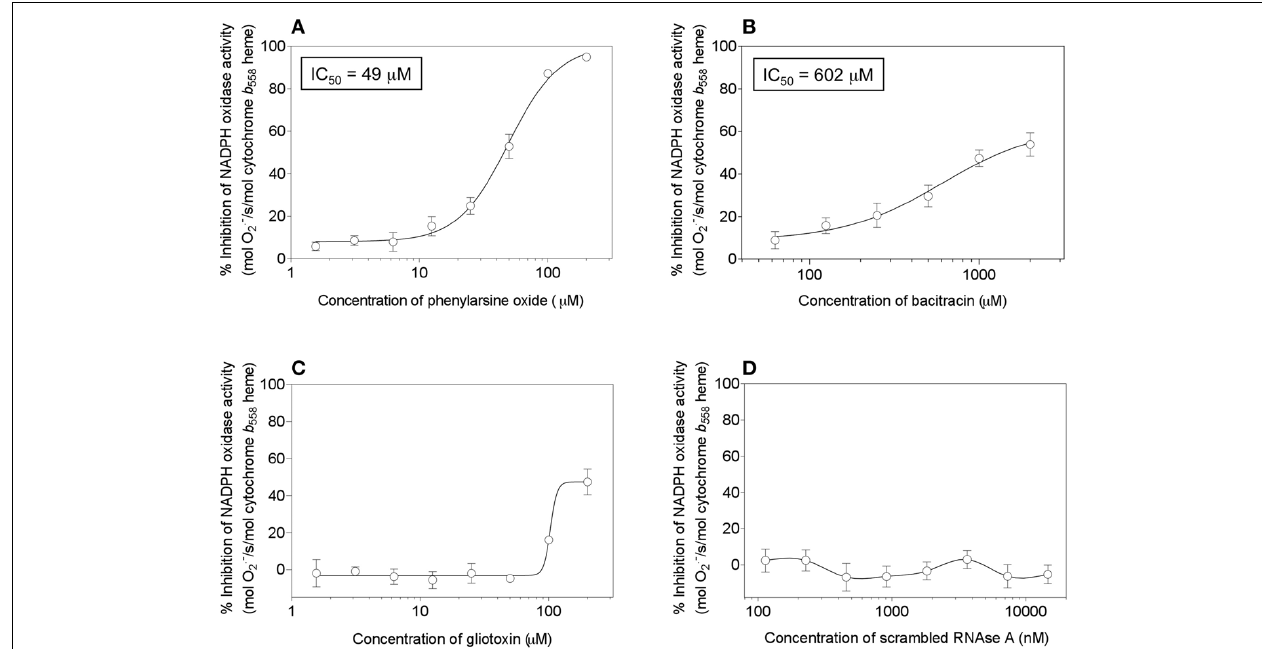
activator, and the addition of 240 μ M NADPH, to initiate O ·− 2 production. The effect of the following inhibitors is described in the figure: (A) phenylarsine oxide (1.56–200 μ M) ; (B) bacitracin (62.5–2000 μ M) ; (C) gliotoxin (1.56–200 μ M), and (D) scrambled RNAse (0.114–14.6 μ M). Results represent means ± SEM of 3 experiments, for each of the inhibitors tested. IC 50 values are indicated for phenylarsine oxide and bacitracin but could not be determined for gliotoxin and scrambled RNAse, due to the absence of curves amenable to kinetic